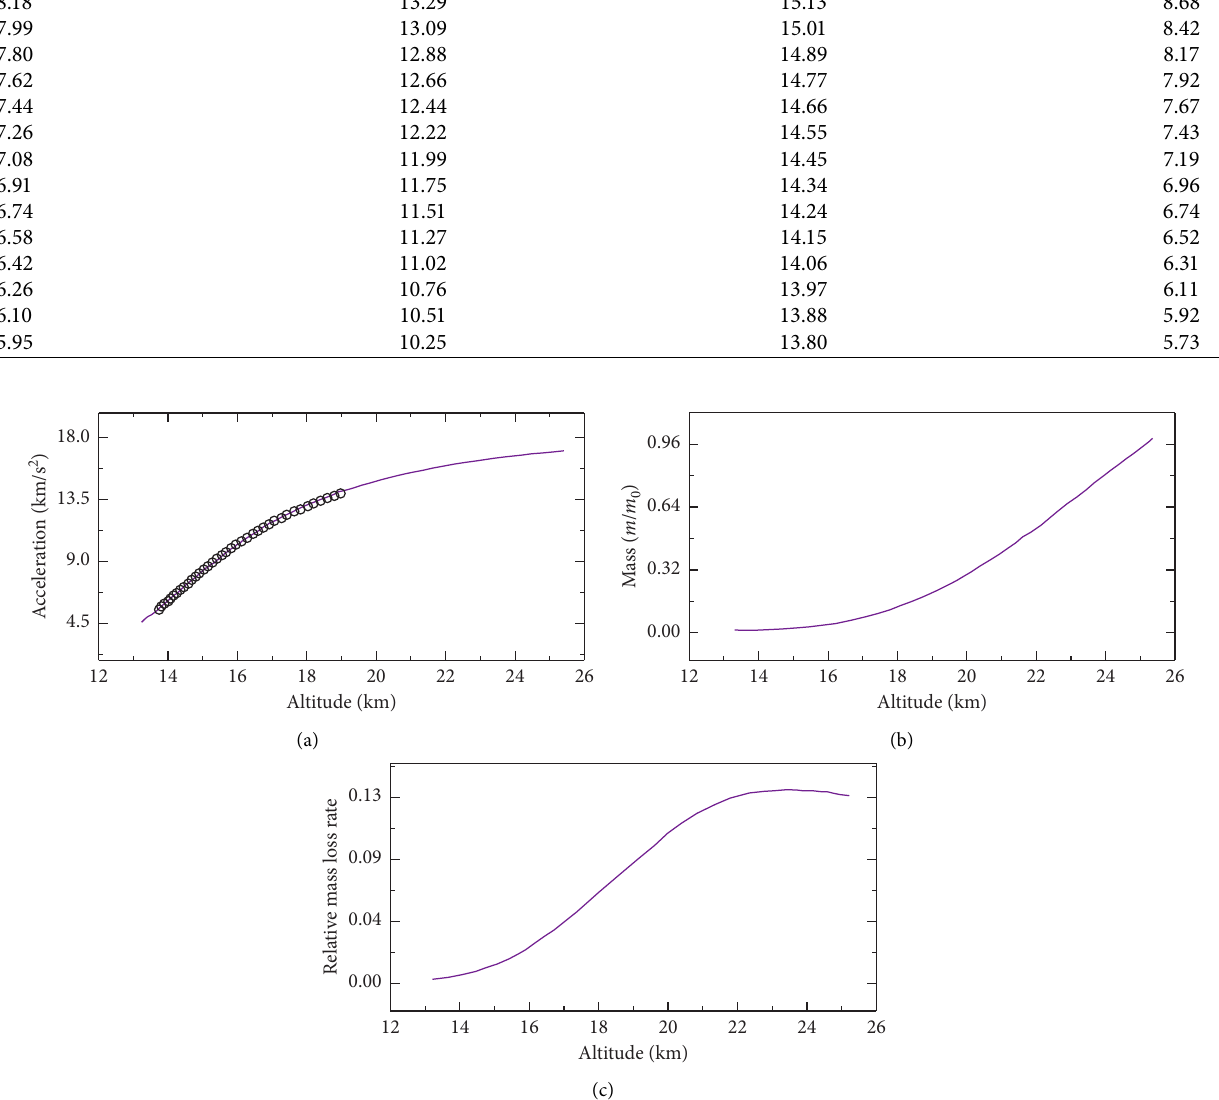
Figure 7: Velocity evolution (a), mass evolution (b), and mass loss rate (c) as a function of altitude for the Chelyabinsk superbolide.